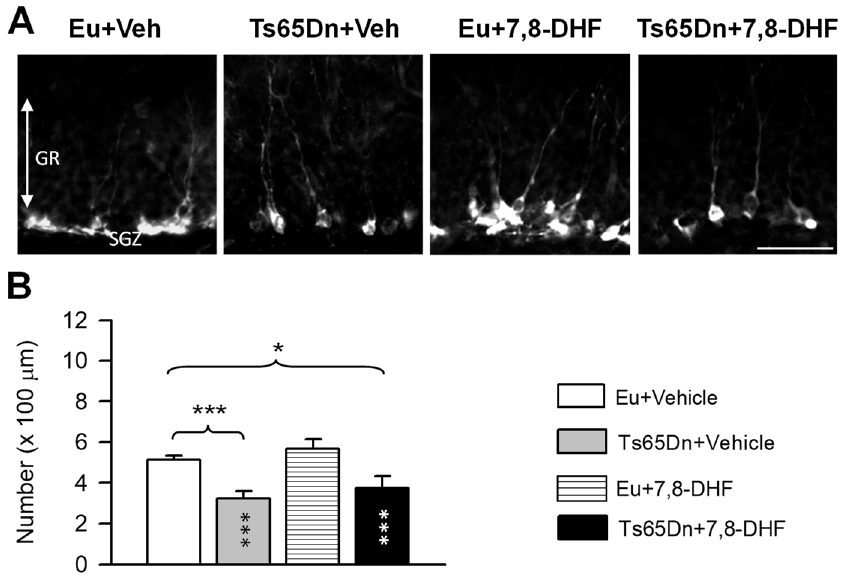
Figure 6. E ff ect of treatment with 7,8-DHF on the number of new granule neurons in the dentate gyrus. ( A ): Sections processed for fluorescent immunostaining for DCX from the dentate gyrus of animals of each experimental group. Calibration bar: 50 µ m. ( B ): Number of DCX-positive cells per unit length of the granule cell layer in untreated euploid ( n = 6) and Ts65Dn mice ( n = 6) and euploid ( n = 4) and Ts65Dn ( n = 4) mice that received 7,8-DHF. Values are mean ± SE. * p < 0.05; *** p < 0.001 (Fisher LSD test after two-way ANOVA). Asterisks in the gray bar indicate a di ff erence between untreated Ts65Dn mice and treated euploid mice; white asterisks in the black bar indicate a di ff erence between treated euploid and treated Ts65Dn mice. Abbreviations: 7,8-DHF, 7,8-dihydroxyflavone; Eu, euploid; Gr, granule cell layer; SGZ, subgranular zone; Veh, vehicle.